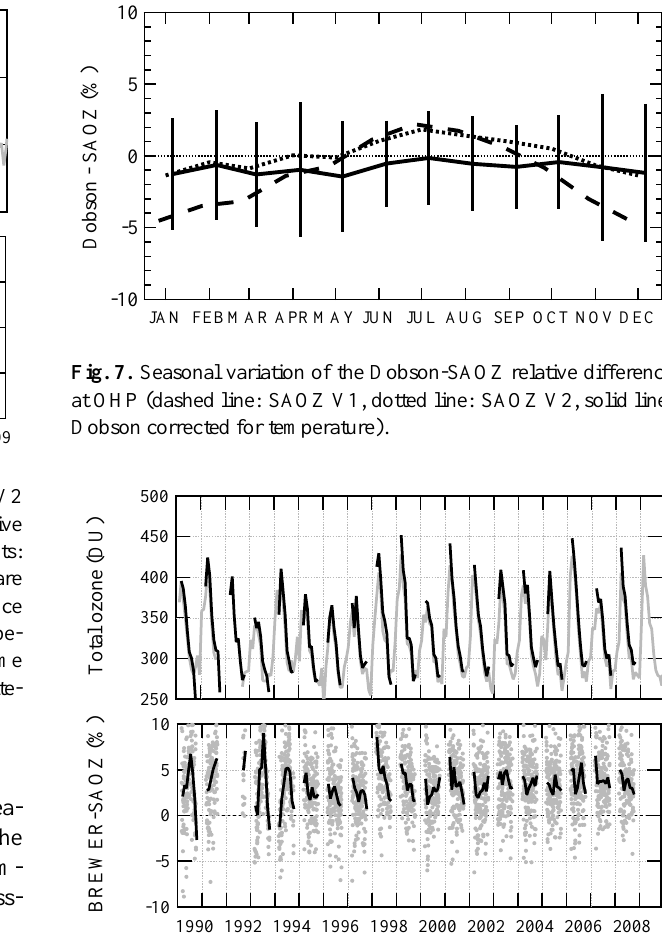
Fig. 8. Comparison between Brewer (black line) and SAOZ V2 (grey line) total ozone columns at Sodankyla. The relative dif- ference Brewer-SAOZ V2 appears on the lower plot (grey dots: daily; black lines: monthly mean). SAOZ data in 1992–1993 are removed because of the Pinatubo eruption. Because of the polar night, Brewer measurements are absent during the winter. Small systematic offsets sometimes also appear, e.g., after 1997 and